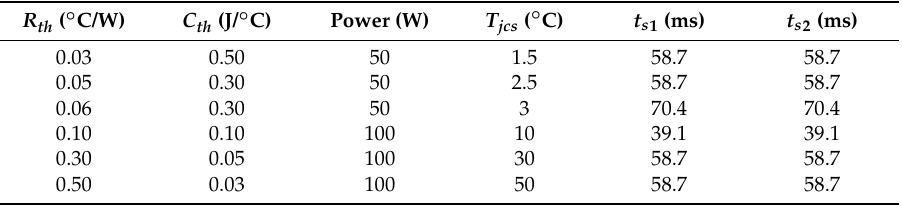
Table 1. Characteristics of single layer when the thermal resistance and capacitance different. R th ( ◦